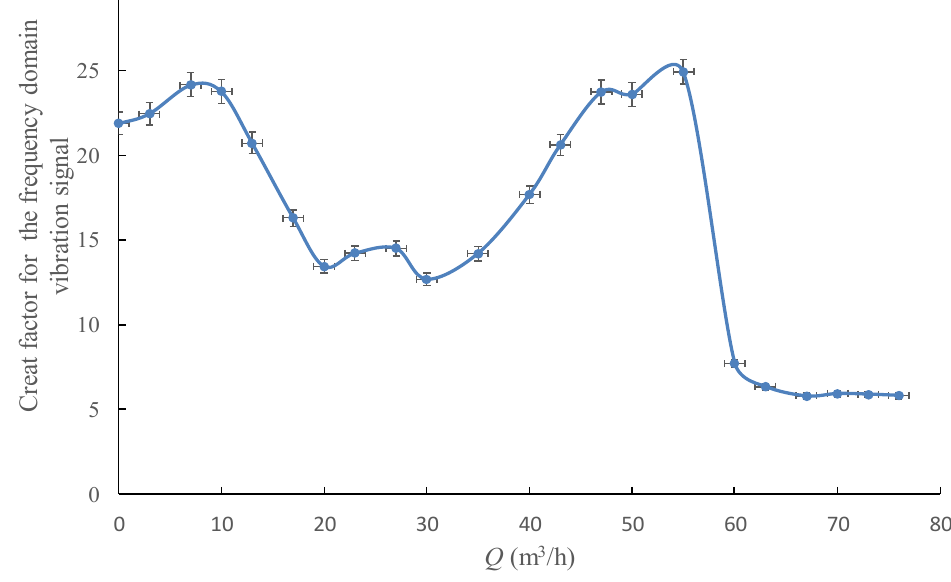
Figure 15. Crest factor for the frequency domain vibration signal under different flowrates.